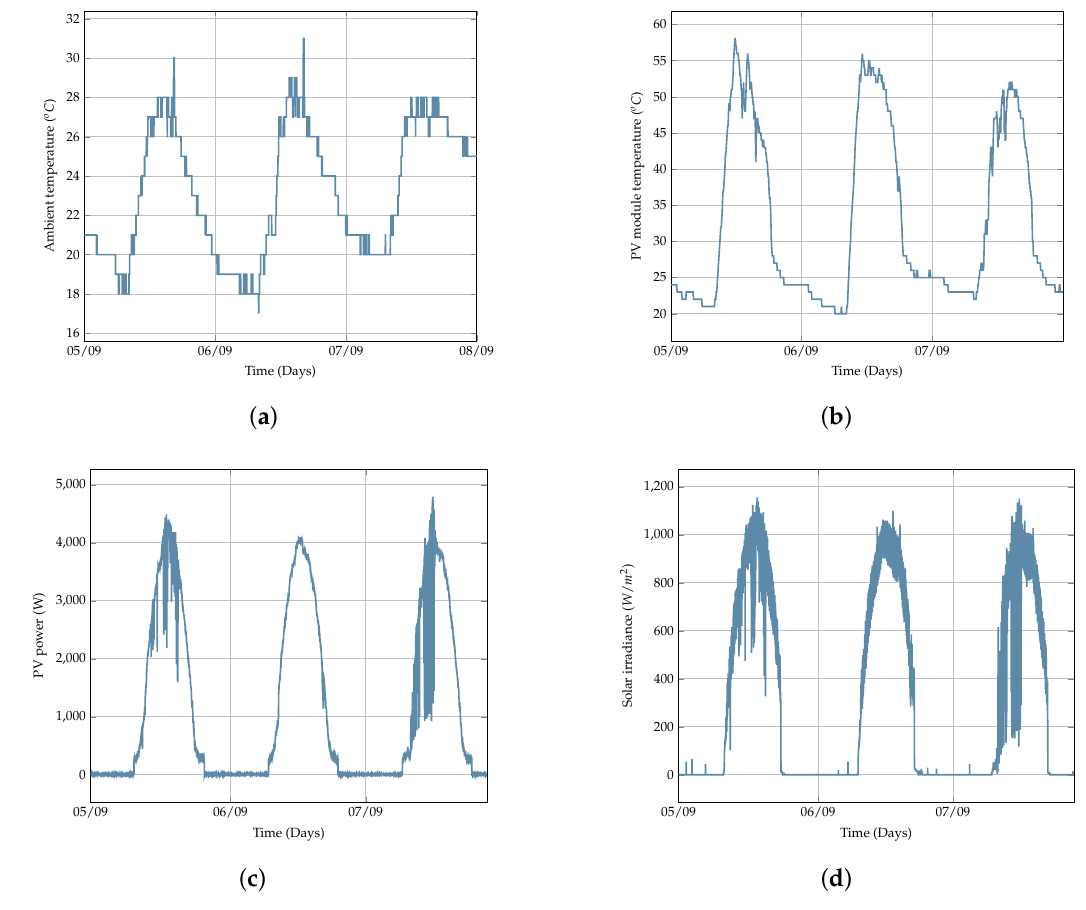
Figure 13. PV installation connected to the grid: monitored power and meteorological data: ( a ) ambient temperature; ( b ) PV module temperature; ( c ) PV installation: power; and ( d ) solar